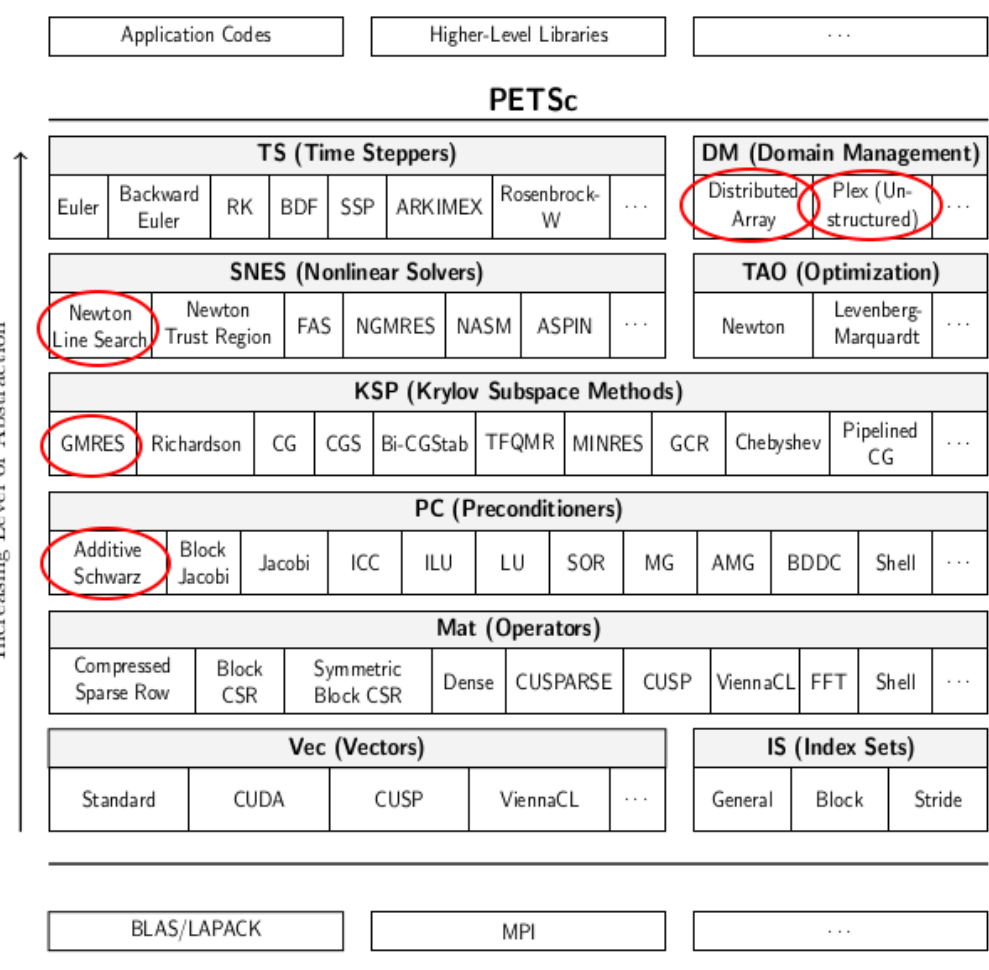
Figure 3. Numerical libraries of PETSc , with emphasis on those used for the distributed power flow (DPF) model